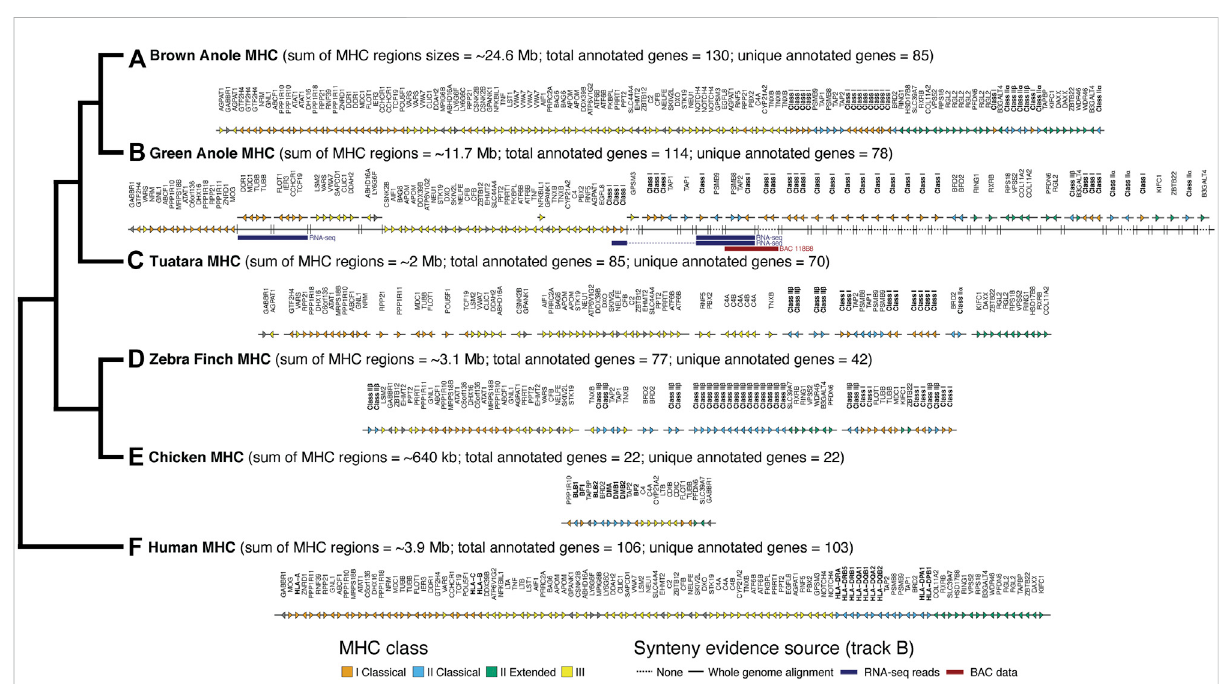
FIGURE 4 Comparative map of genes identi fi ed in MHC regions of six amniotes: (A) brown anole, (B) green anole, (C) tuatara, (D) zebra fi nch, (E) chicken, and (F) human.Thetotalapproximatesize(sumofregionsizesacrossscaffolds)andtotalanduniquenumberofannotatedgenesintheseregionsfor eachspeciesareindicatedinparentheses.TheestimatedsizesoftheMHCregionsre fl ectthesummeddistancesbetweenthe fi rstandlastannotated MHC gene on each chromosome/scaffold containing MHC genes. The phylogeny to the left shows the evolutionary relationships between each species. For green anole, we used whole-genome alignments and secondary evidence from BAC and RNA-seq data to infer the placement of scaffoldsintheincompletely-assembledMHCregion.Weuseasolidorbrokenlinetoindicatescaffoldswhereplacementwasorwasnotcon fi dently inferred based on the whole genome alignments. Where placement was not con fi dently inferred, scaffolds were arranged based on the ordering of genes re fl ected in other species where the MHC regions were well assembled. RNA-seq reads (various read depths) and BAC data spanning multiple scaffolds,whichprovidesincreasedcon fi dencefortheplacementandorientationofscaffolds,arealsoindicatedusingblue(RNA-seq)andred(BAC) bars.Fortuataraandzebra fi nch,weroughlyorderedanyscaffoldswithMHCgenesbasedonorderingintheotherspecies.Importantly,theabsolute genedirection(i.e.,strand)isnotcon fi dentlyinferredbetweenscaffoldsforspecieswheretheMHCisassembledonmultiplescaffolds.Notethatour MHC annotations for the well-studied human and chicken genomes are missing some genes annotated in previous, more detailed studies of the MHCs of those species. See Supplementary Table S9 for a full summary of the chromosomal locations of MHC genes in each species and Supplementary Figure S9 for a graphical summary of the arrangement of green anole scaffolds in the MHC region based on the whole genome alignment with the brown anole